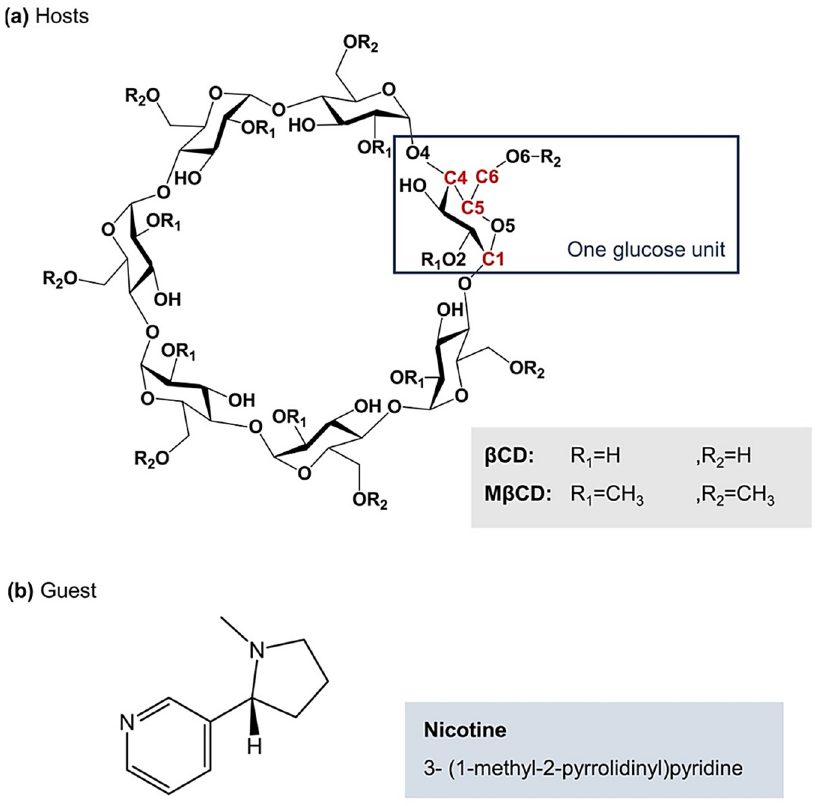
Figure 1. Schematic representation of ( a ) the glucose unit and atomic numbering of β CD and M β CD and ( b ) nicotine structure (C1, C4, C5, and C6 are the carbon atom positions with numeric indexes in each glucose